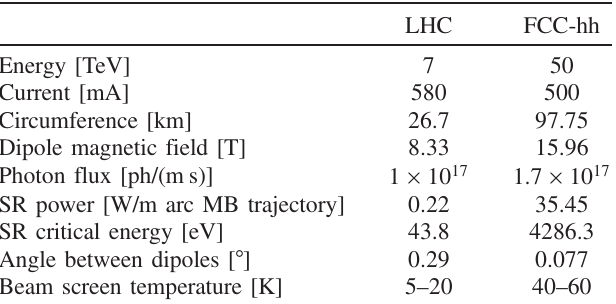
TABLE I. Comparison of the LHC ’ s and the FCC-hh ’ s relevant baseline parameters